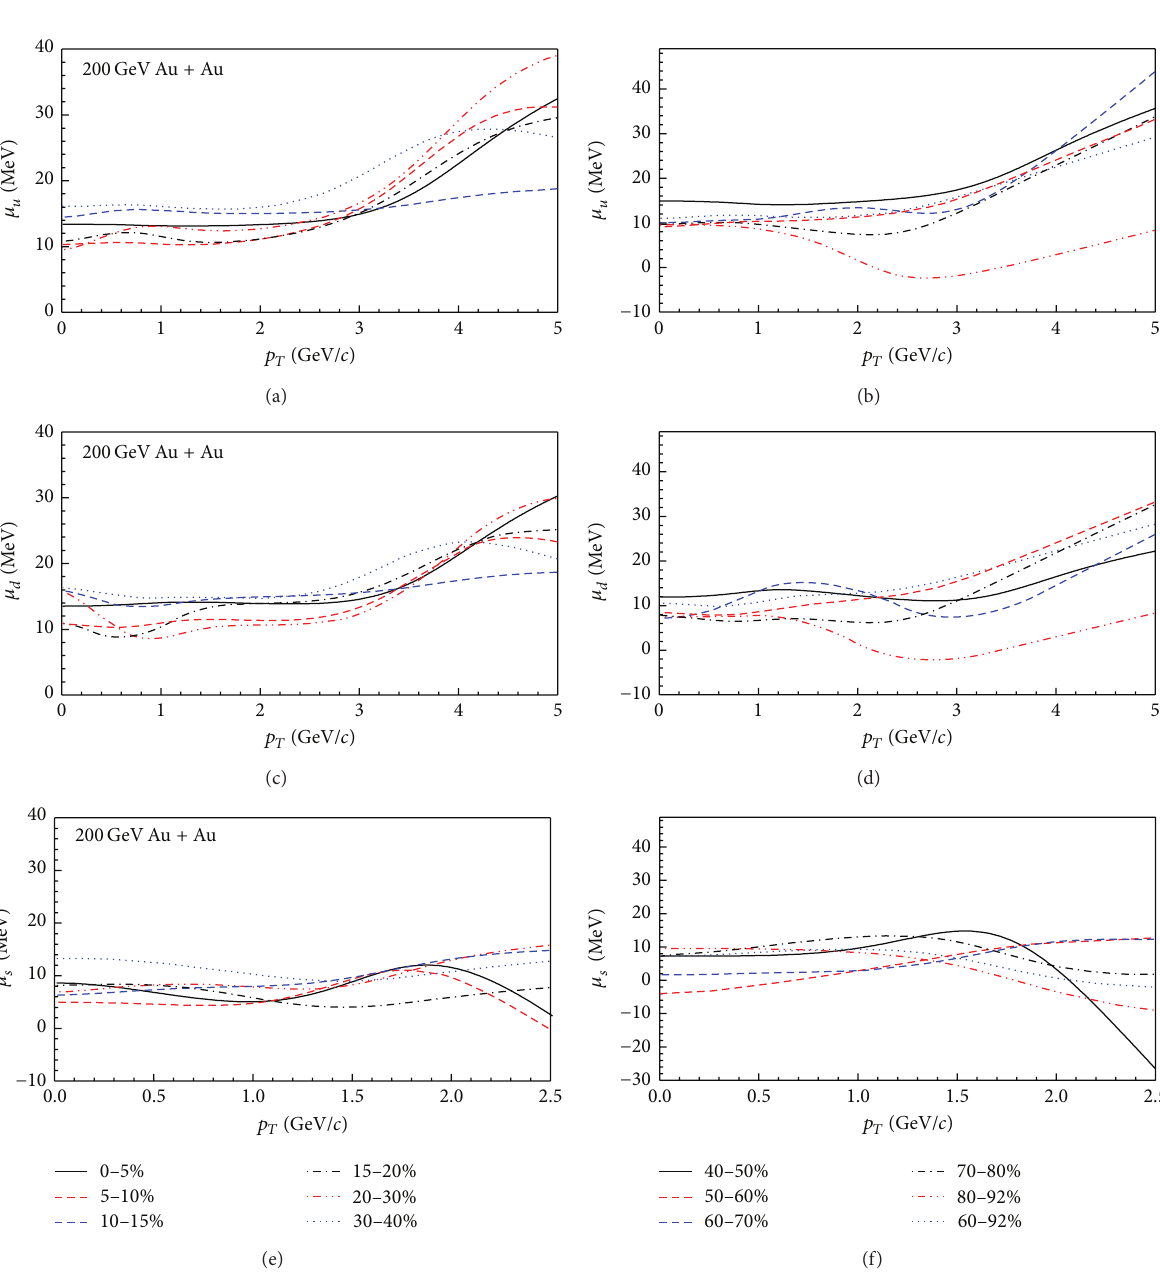
system are not too strong, and the interacting system may stay at the state of QGP. The small chemical potentials of quarks result in small chemical potentials of hadrons.